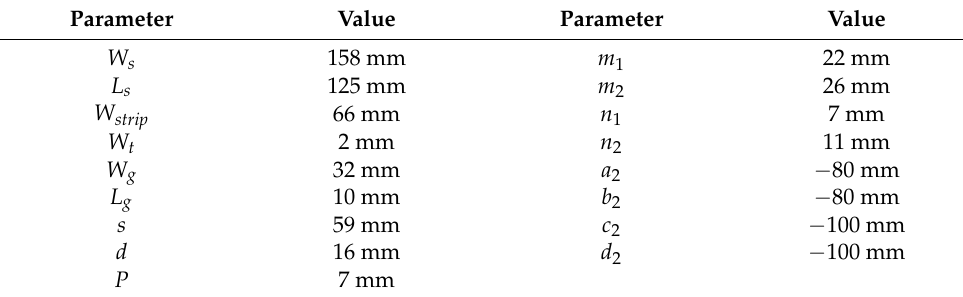
Table 1. Final optimum parameter values of the proposed